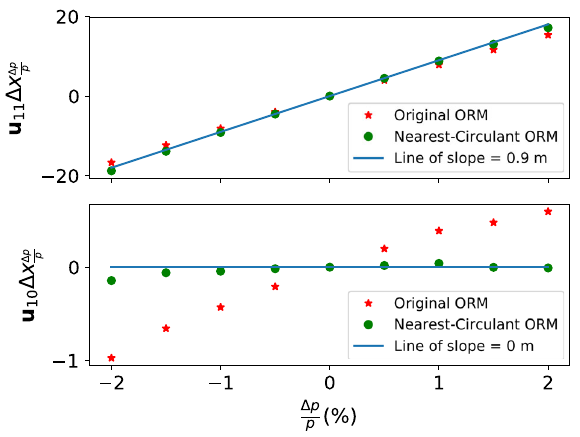
FIG. 12. Coupling of experimentally measured dc shift Δ x (mm) in the horizontal closed orbit to the last two columns of the U matrices ( u u 11 and 10 ) of the original ORM and its nearest- circulant